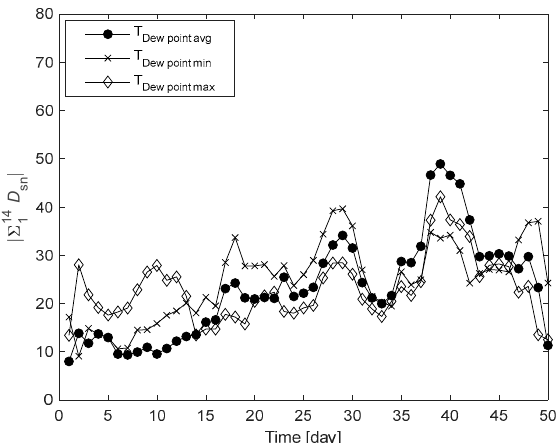
Figure 7. The variation of the classification potential ( D sn values) for net blotch risk levels when applying the daily minimum, maximum and average values of the dew point temperature. Day 1 is the beginning of the growing season.